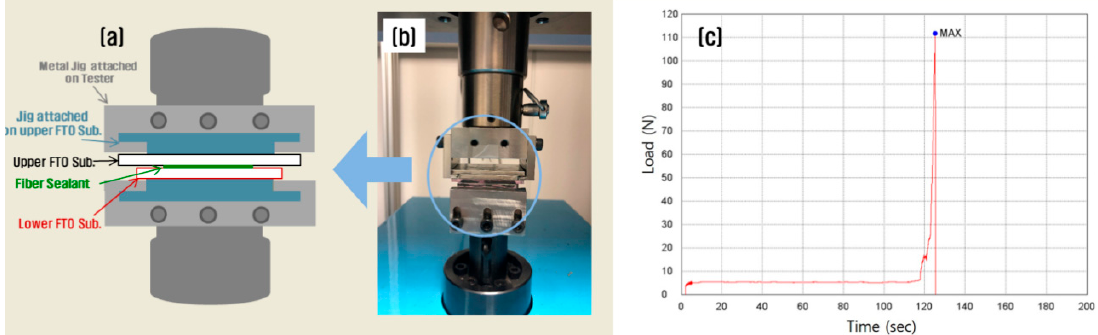
Figure 10. ( a ) Schematic diagram of zig mounted with FTO substrates; ( b ) universal tensile tester mounted with zig; ( c ) tensile load changes with time for the laser-sealed FTO substrate (laser power of 35 W, laser scan velocity of 40 mm/s, laser scanning cycle of 300, and preheating of 190 ℃ ).